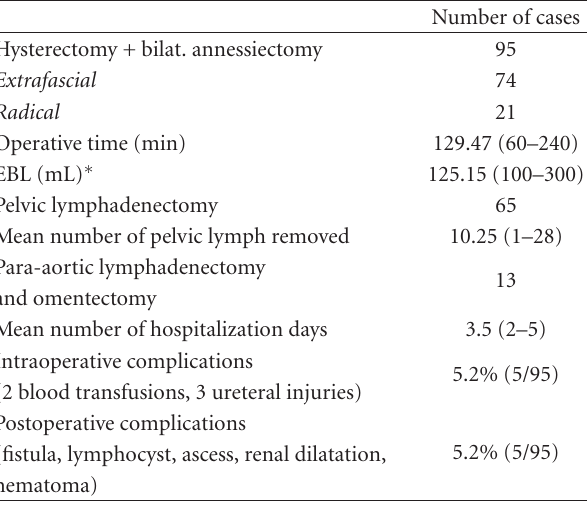
Table 2: Perioperative data.